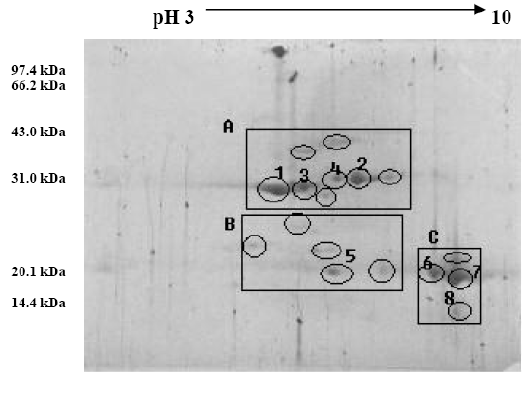
Figure 3. Two-dimensional gel electrophoresis of walnut proteins. Separation was performed in the pH region of 3–10 and followed by staining using blue colloidal method. Major proteins appeared were